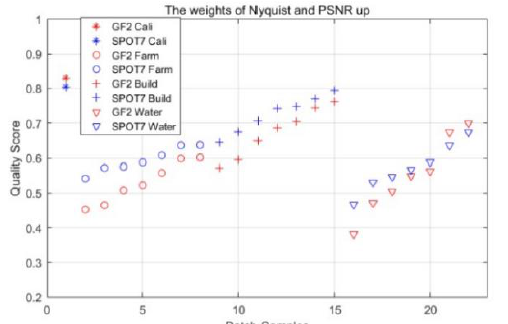
Figure 8. The results with high Nyquist and PSNR weight Thirdly, contrary to the above experiment, the weights of edge intensity and average gradient were increased, and the weights of Nyquist and PSNR gradient were decreased. The new weight is shown at table 4, No.3. The result is shown in figure 9. Overall, the quality of GF2 image is higher than SPOT7. But the differences of farmland and building patches’ image quality are not obvious.